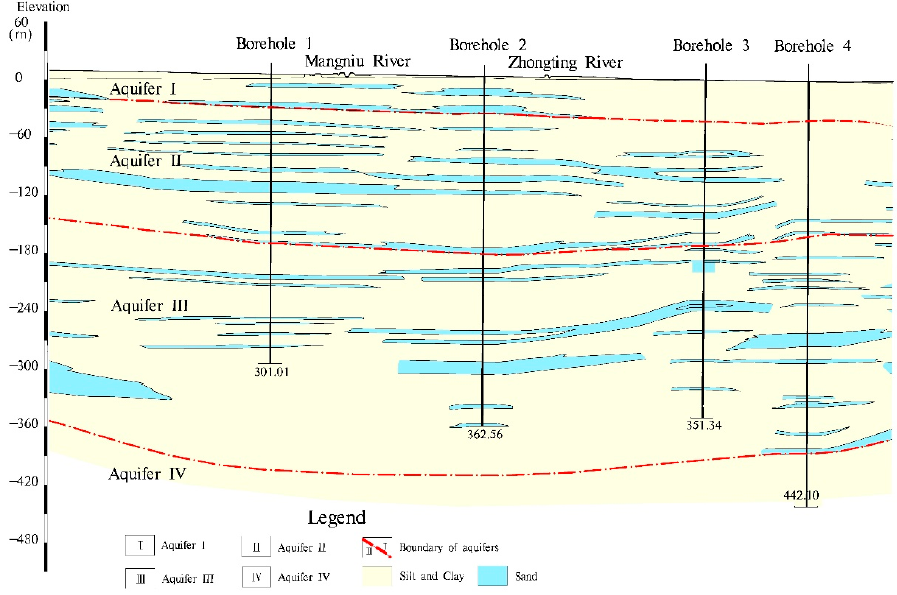
Figure 2. Hydrogeological cross-section along A–A’.